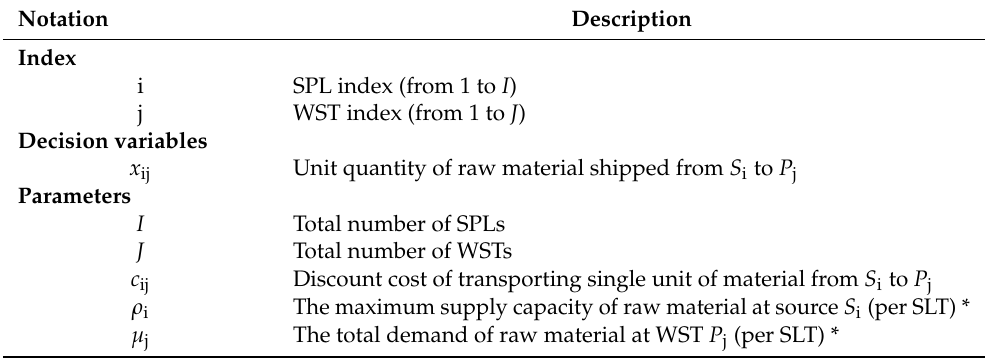
Figure 2. Sketch of the proposed material logistics LP model. Table 1. Description of notations used in LP